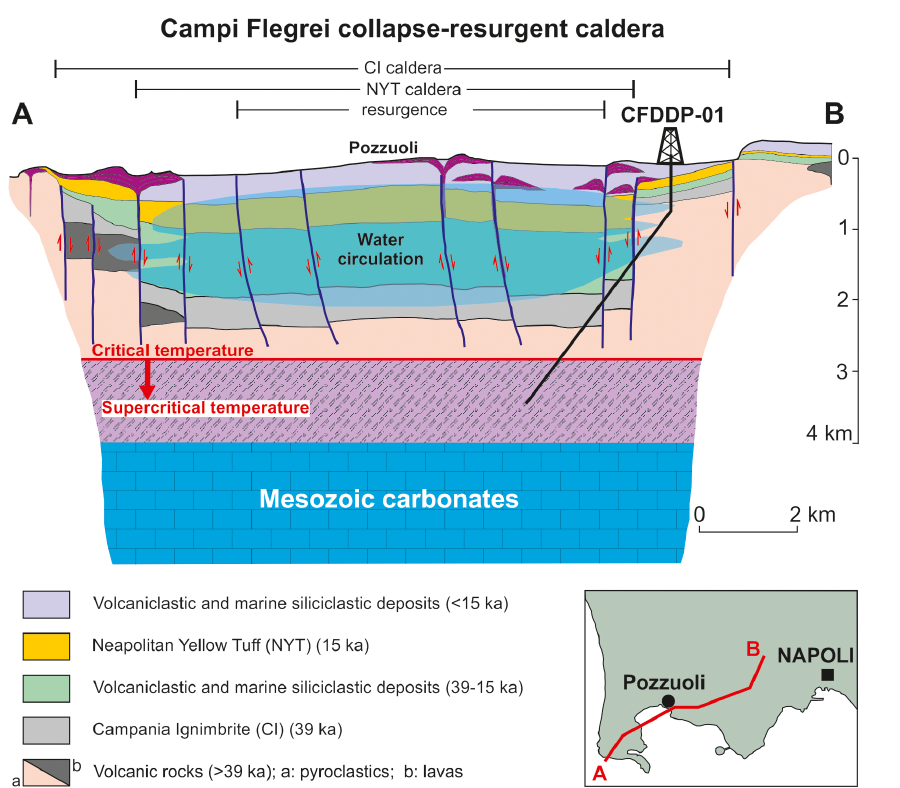
Figure 7. Illustrated section of the Campi Flegrei caldera structure indicating the targets of the proposed onshore (ICDP) drill site (CFDDP- 01). The reconstruction is mostly based on geophysical and geological data, affected by large uncertainties. The depth limit critical water temperature is constrained by previous drillings in the area (AGIP, 1987). Modified after De Natale and Troise (2011).